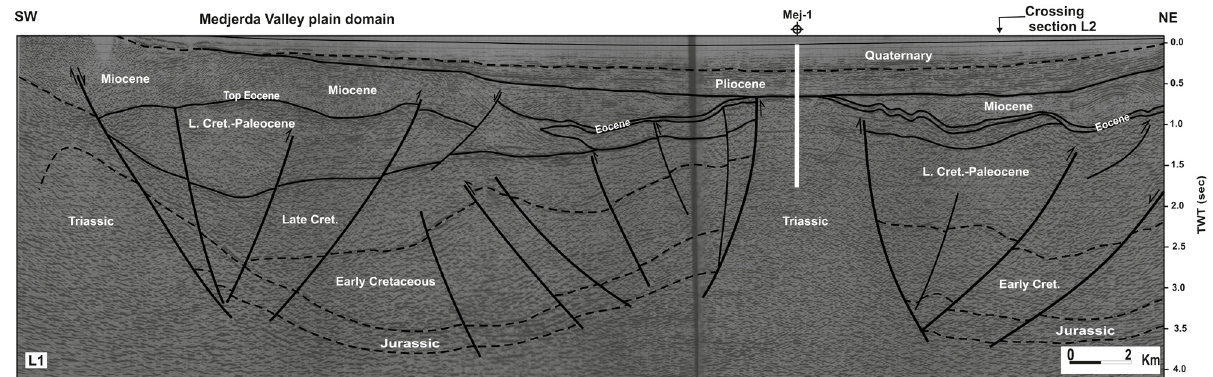
Figure 9. Interpreted seismic line L1 across the Medjerda Valley Plain (location shown in Figure 1), illustrating distribution of the Mesozoic and Cenozoic strata depositions and their relation with the NW-trending faults and associated Triassic evaporites.